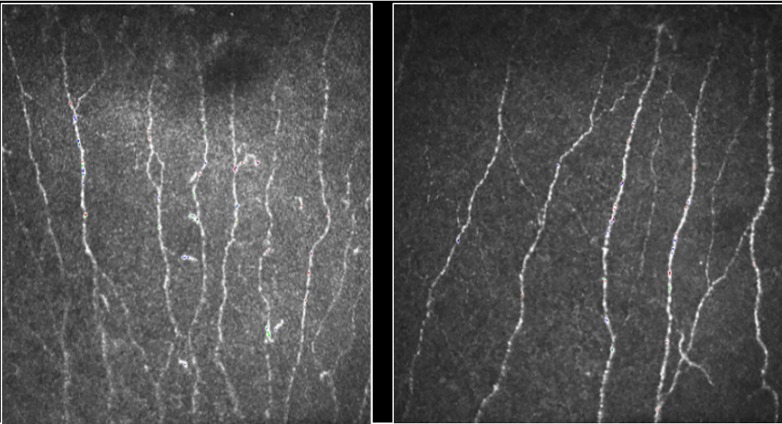
CCM images at original image x 700 times magnification.The figure on the left is from a 25-year old HC with CNFD at 61.89 no./mm2 (>75th centile) while on the right is from a 71-year old HC with CNFD at 40.12/mm2 (<25th centile).